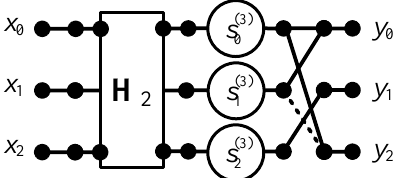
Figure 2. Signal flow graph of the algorithm for computing the 3-point